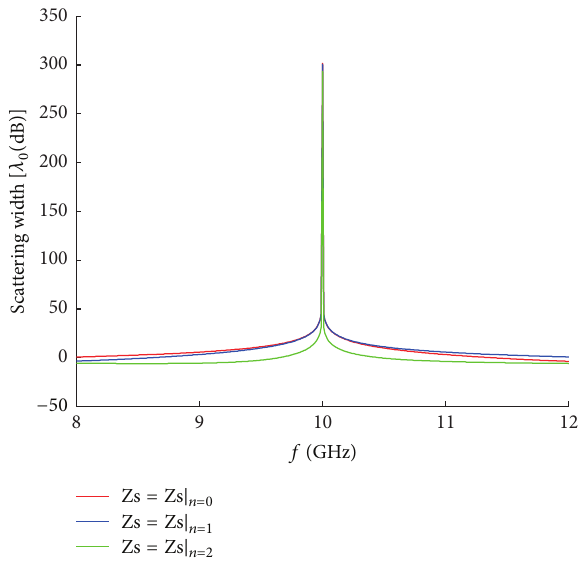
Figure 6: The total scattering widths versus frequency, in which dif- ferentsurfaceimpedanceisconsidered,includingthecorresponding monopole, the dipole, and the quadripole cases (color